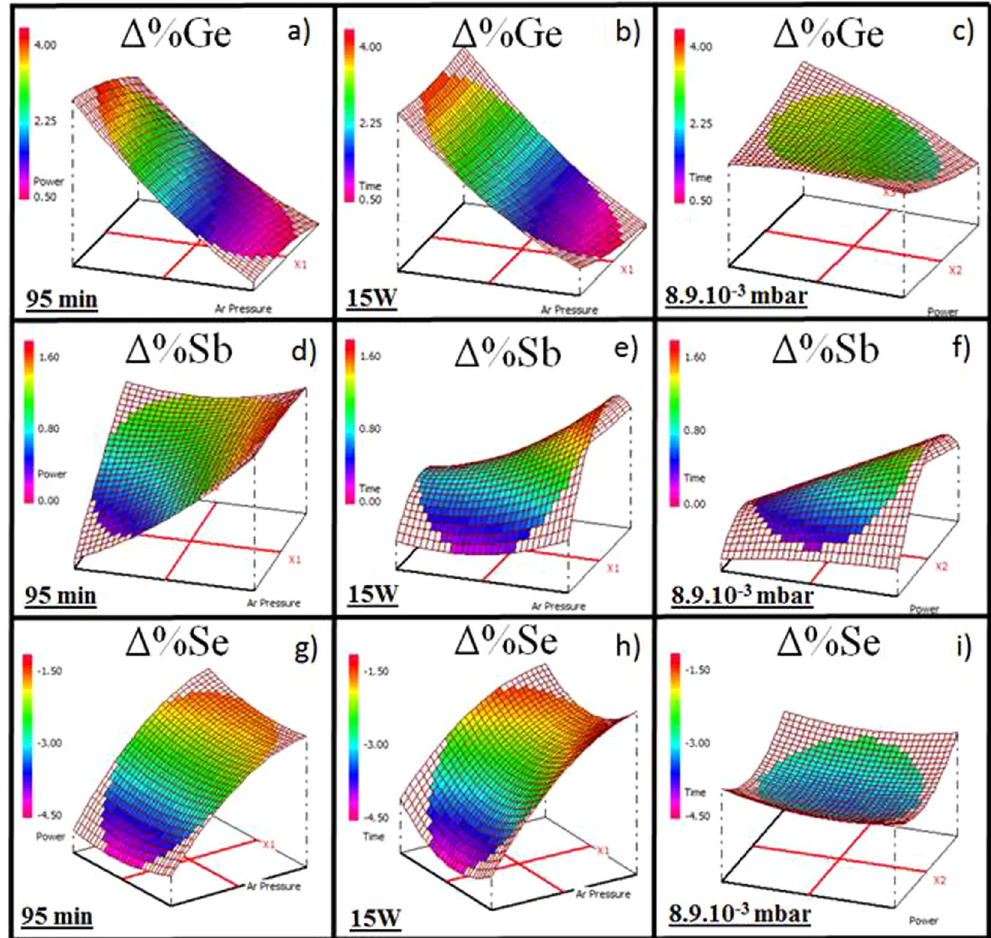
Figure 2. Variation of the chemical composition of the Ge 12.5 Sb 25 Se 62.5 thin films for a fixed deposition time 95 min ( a ) Δ %Ge, ( d ) Δ %Sb, ( g ) Δ %Se, for a fixed working power 15 W ( b ) Δ %Ge, ( e ) Δ %Sb, ( h ) Δ %Se, for a fixed Ar pressure 8.9.10 − 3 mbar ( c ) Δ %Ge, ( f ) Δ %Sb, ( i ) Δ